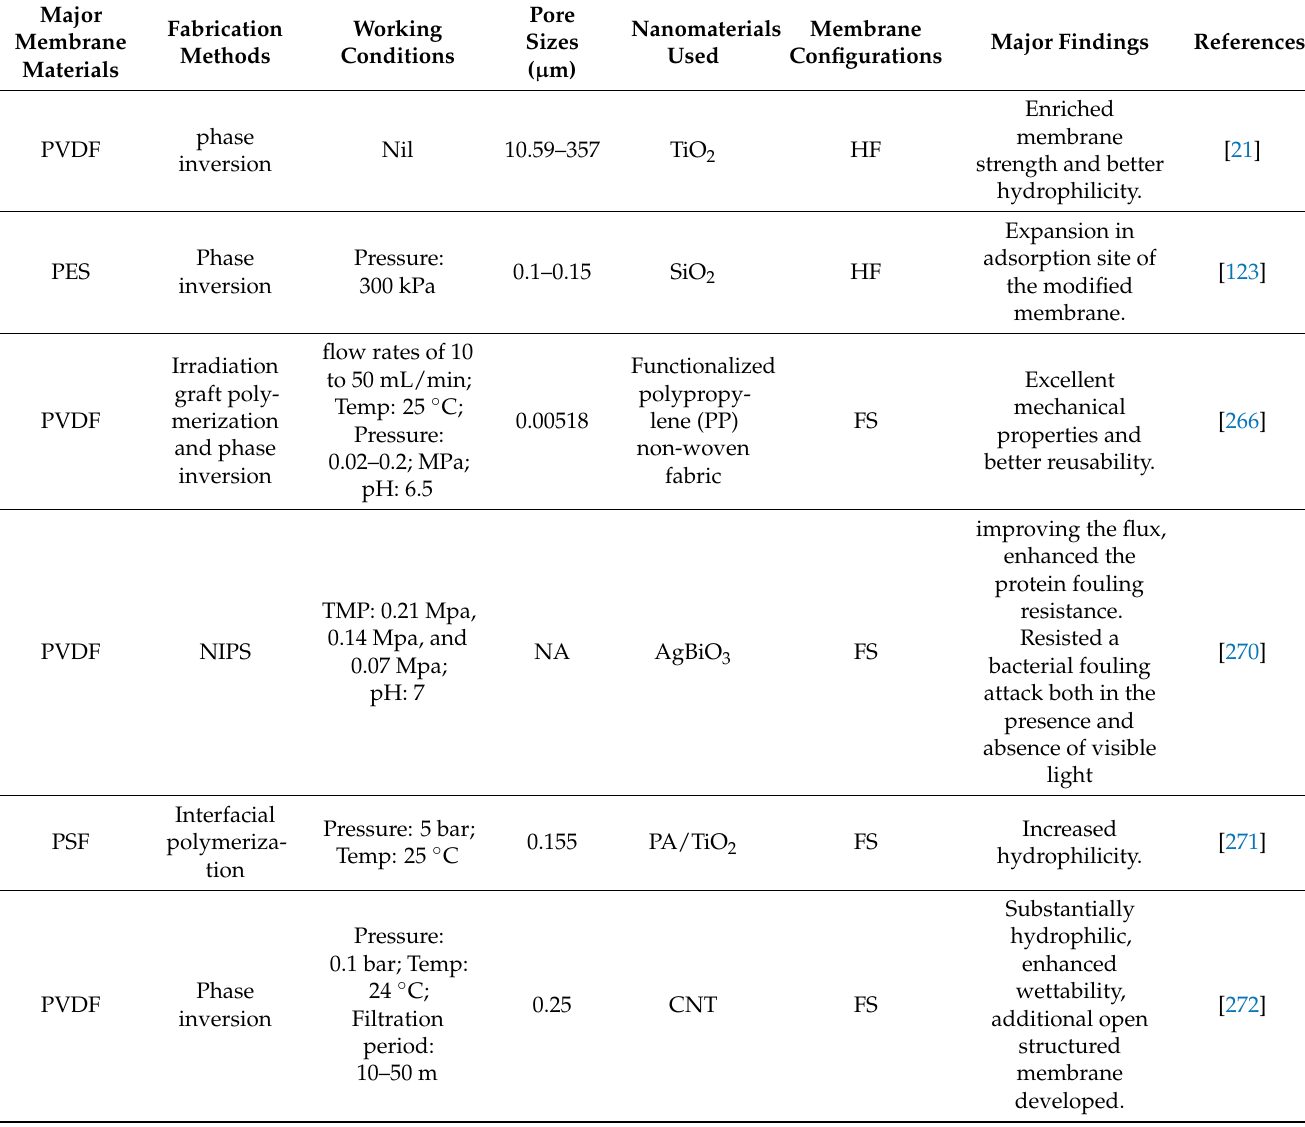
Table 3. Major membrane materials, fabrication techniques, modules, and nanomaterials used in membrane